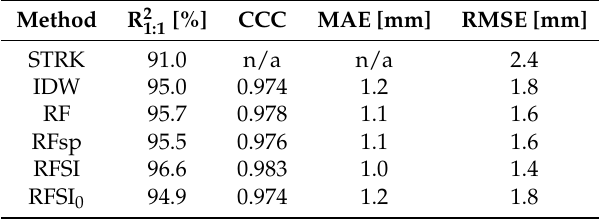
Table 7. Accuracy metrics of all six prediction methods as assessed using nested 10-fold LLOCV